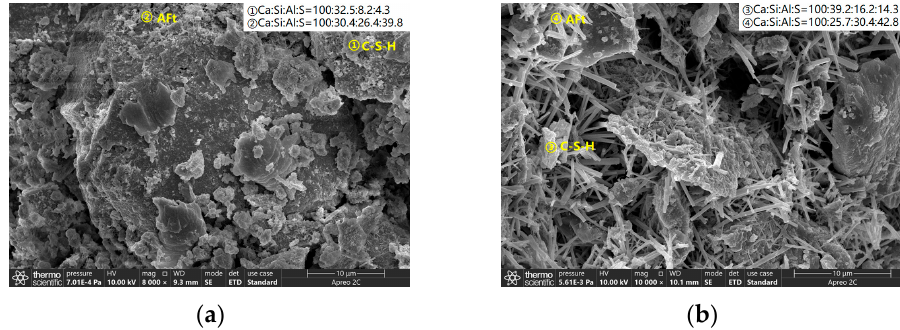
Figure 9. The microstructure of cement samples at 0.5 h: ( a ) PA0-045-0.5h; ( b ) PA9-045-0.5h. The microstructure of PA0-045 and PA9-045 at 60 d are shown in Figure 10. Several hydration products, including calcium hydroxide (CH), C-S-H gel, and ettringite (AFt), were observed on the surface of the PA0-045 sample. PA9-045 contained similar hydration products, more ettringites, and less calcium hydroxide, as indicated by the results of the XRD analysis. Since PA9-045 had more microscopic pores that were mainly distributed on the disordered overlapping positions of ettringites, it is assumed that PA0-045 possesses a denser microstructure.